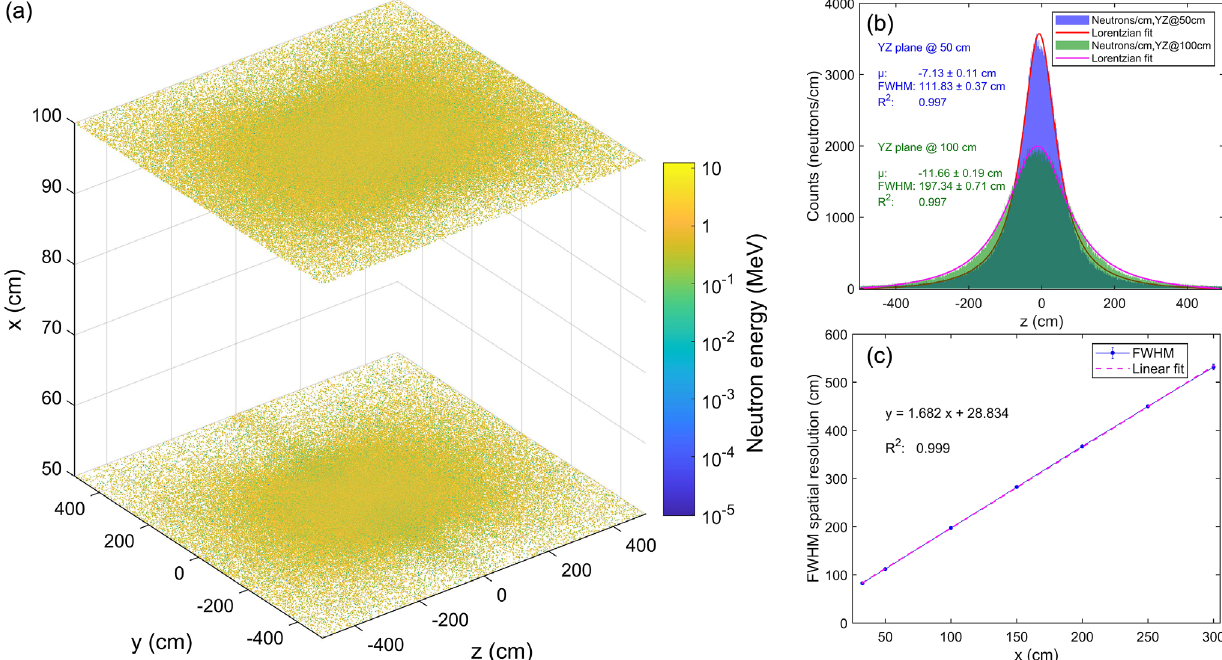
FIG. 32. (a) The neutron hit maps on the YZ plane respectively at 50 and 100 cm for the number of lost particles set as 10 9 , (b) the neutron one-dimensional distribution by projecting the 2D hit maps on the z axis, and (c) the spatial resolution of neutron distribution vs the positions of YZ